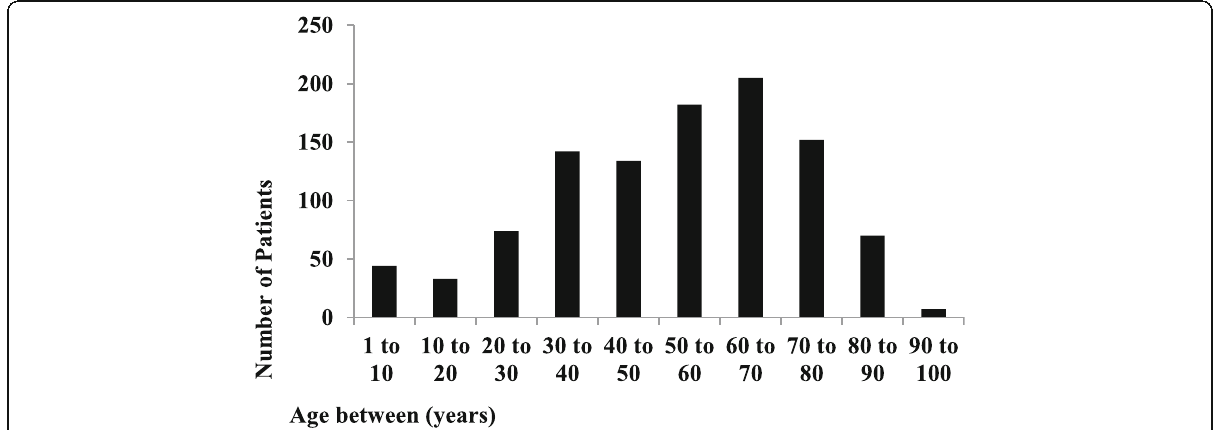
Fig 1 Distribution of age in total population of patients with brain and other nervous system